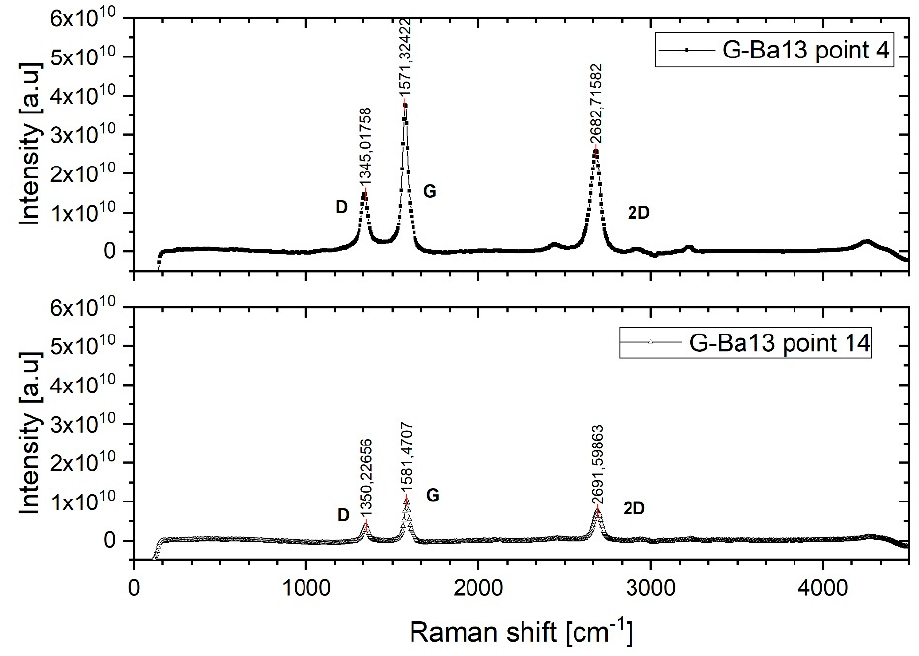
Figure 3. SEM picture of the graphene flakes after drying the ink: ( a ) Low magnification picture. ( b ) High magnification picture.